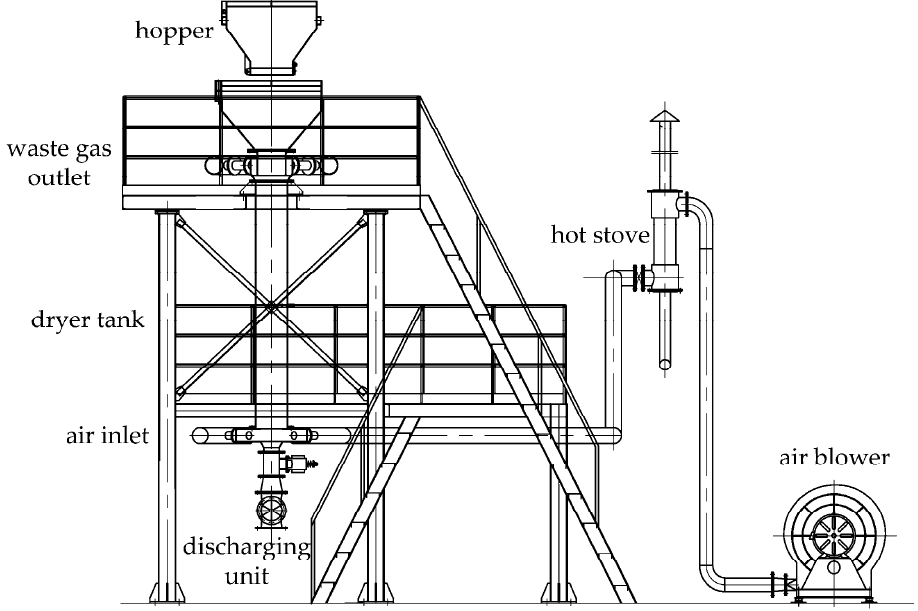
Figure 2. Scheme of shaft dryer.